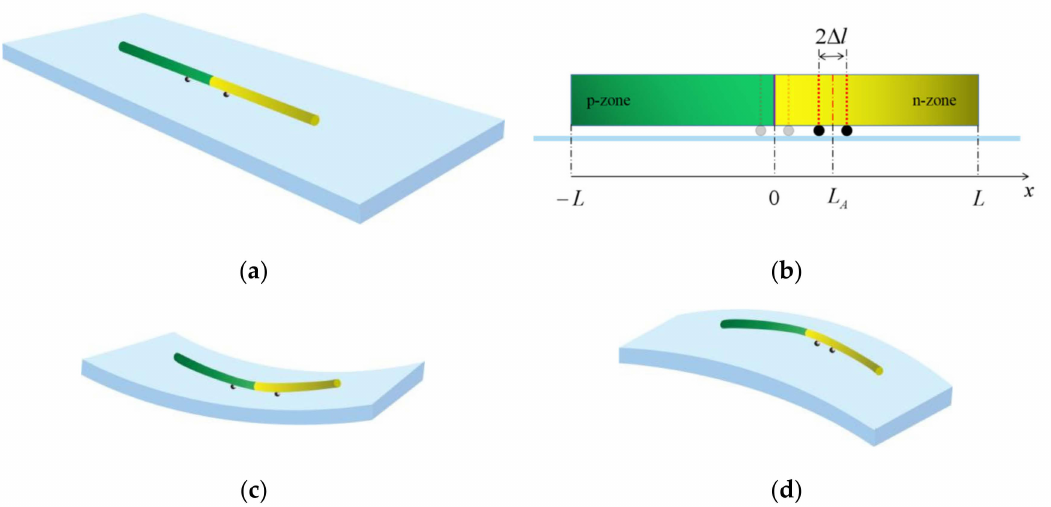
Figure 1. MIAPB formed by a pair of tensile/compressive stresses for the case of a PN junction in a ZnO system. ( a ) Unloaded 3D PN junction structure, ( b ) Front view of the structure, ( c ) Compressive- mode MIAPB induced by bending substrate up and ( d ) Tensile-mode MIAPB induced by bending substrate